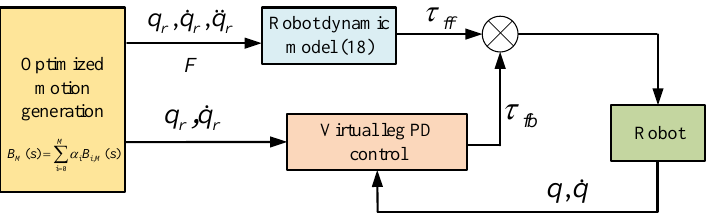
Figure 12. The diagram of robot